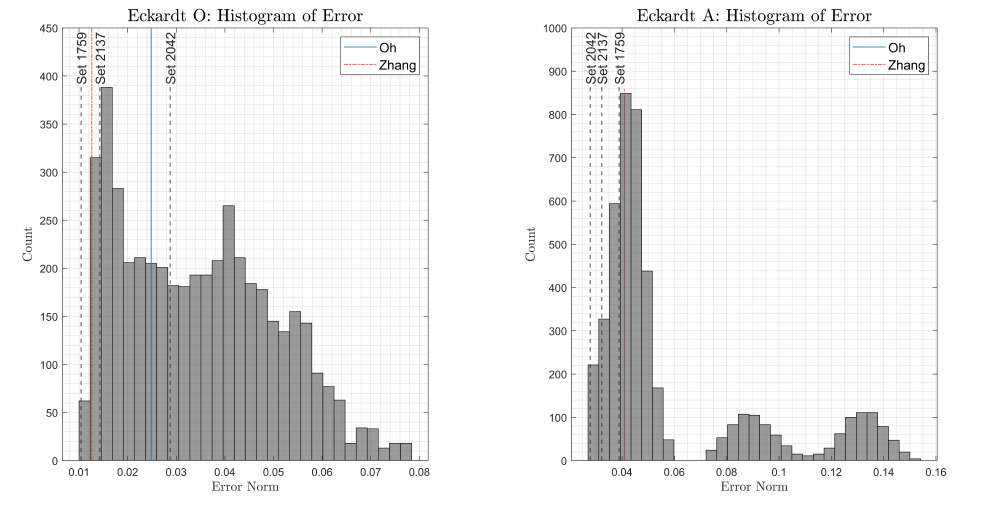
Figure 7. Histograms of loss model sets split according to their deviation from experiment, which is evaluated using Equation (61): ( left ) Eckardt O; ( right ) Eckardt